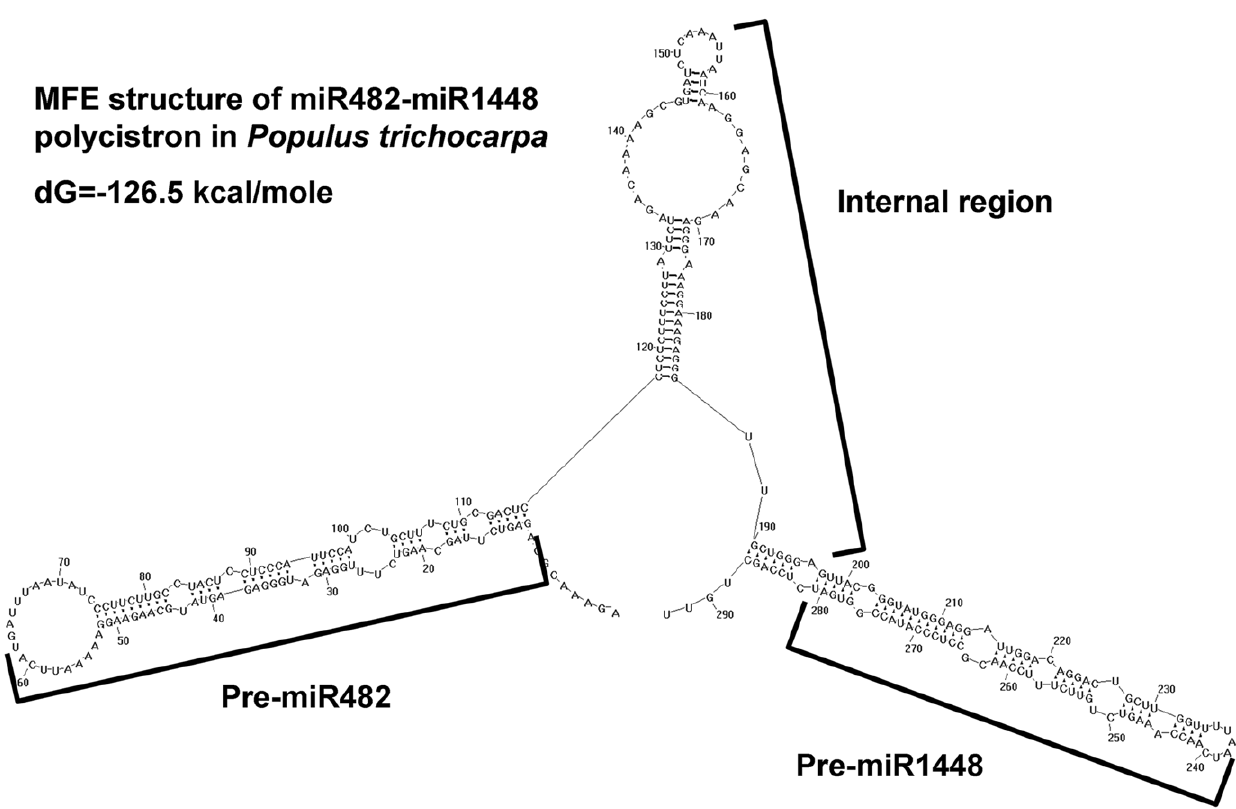
Figure 4. The tertiary structure of miR482-miR1448 polycistron in Populustrichocarpa . The MFE structure prediction used RNAstructure v5.3 showed that the pre-miR482 and pre-miR1448 could form a stem-loop structure, meanwhile, the internal region in miR482-miR1448 polycistron also could fold back on itself to form a helix.